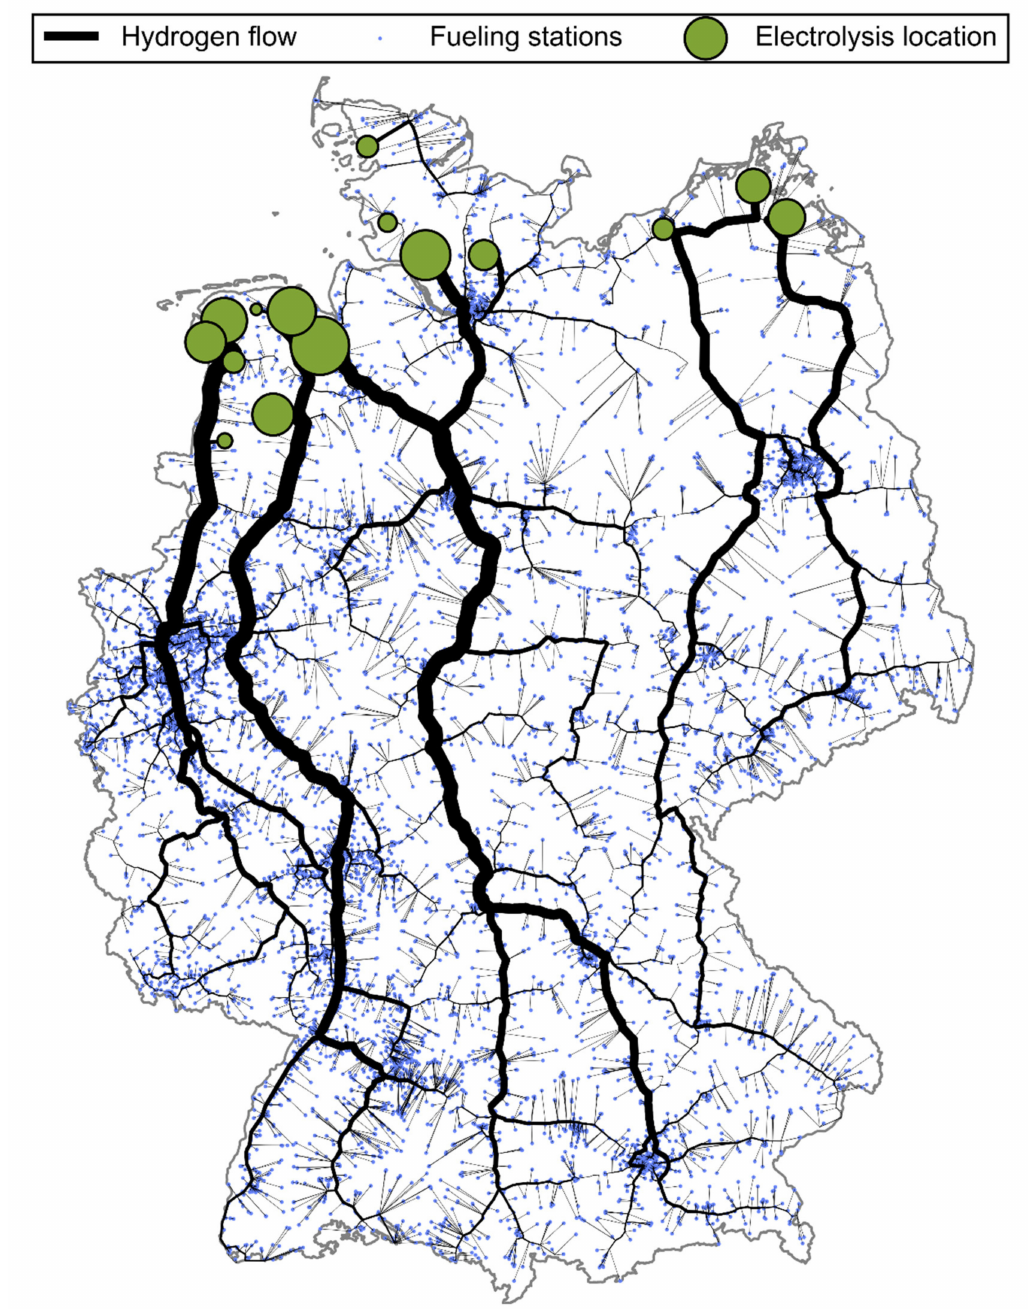
Figure 3. Routing of CGH 2 , LH 2 and LOHC technologies in Germany in 2050 with the number of trucks defined by the thickness of the black